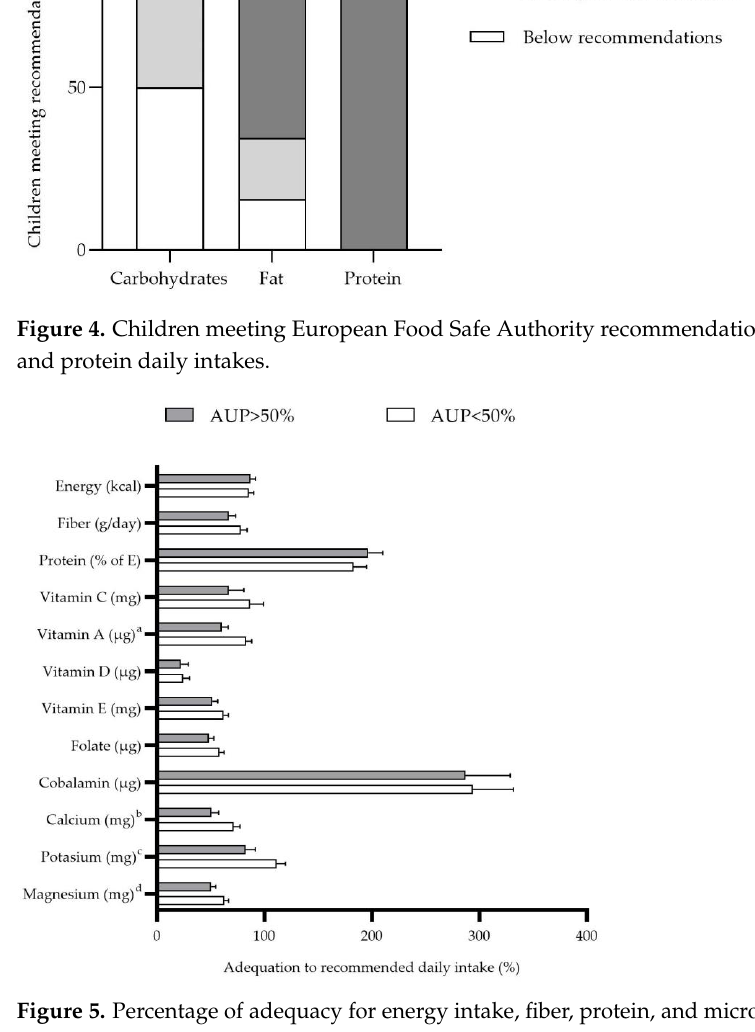
Figure 5. Percentage of adequacy for energy intake, fiber, protein, and micronutrients, recom- mended daily intake in children with celiac disease according to percentage of energy intake from ultra-processed food (n = 58). Values are shown as mean (standard error). Model is adjusted for age, sex, and body mass index (BMI). a p = 0.009; b p = 0.027; c p = 0.023; d p =